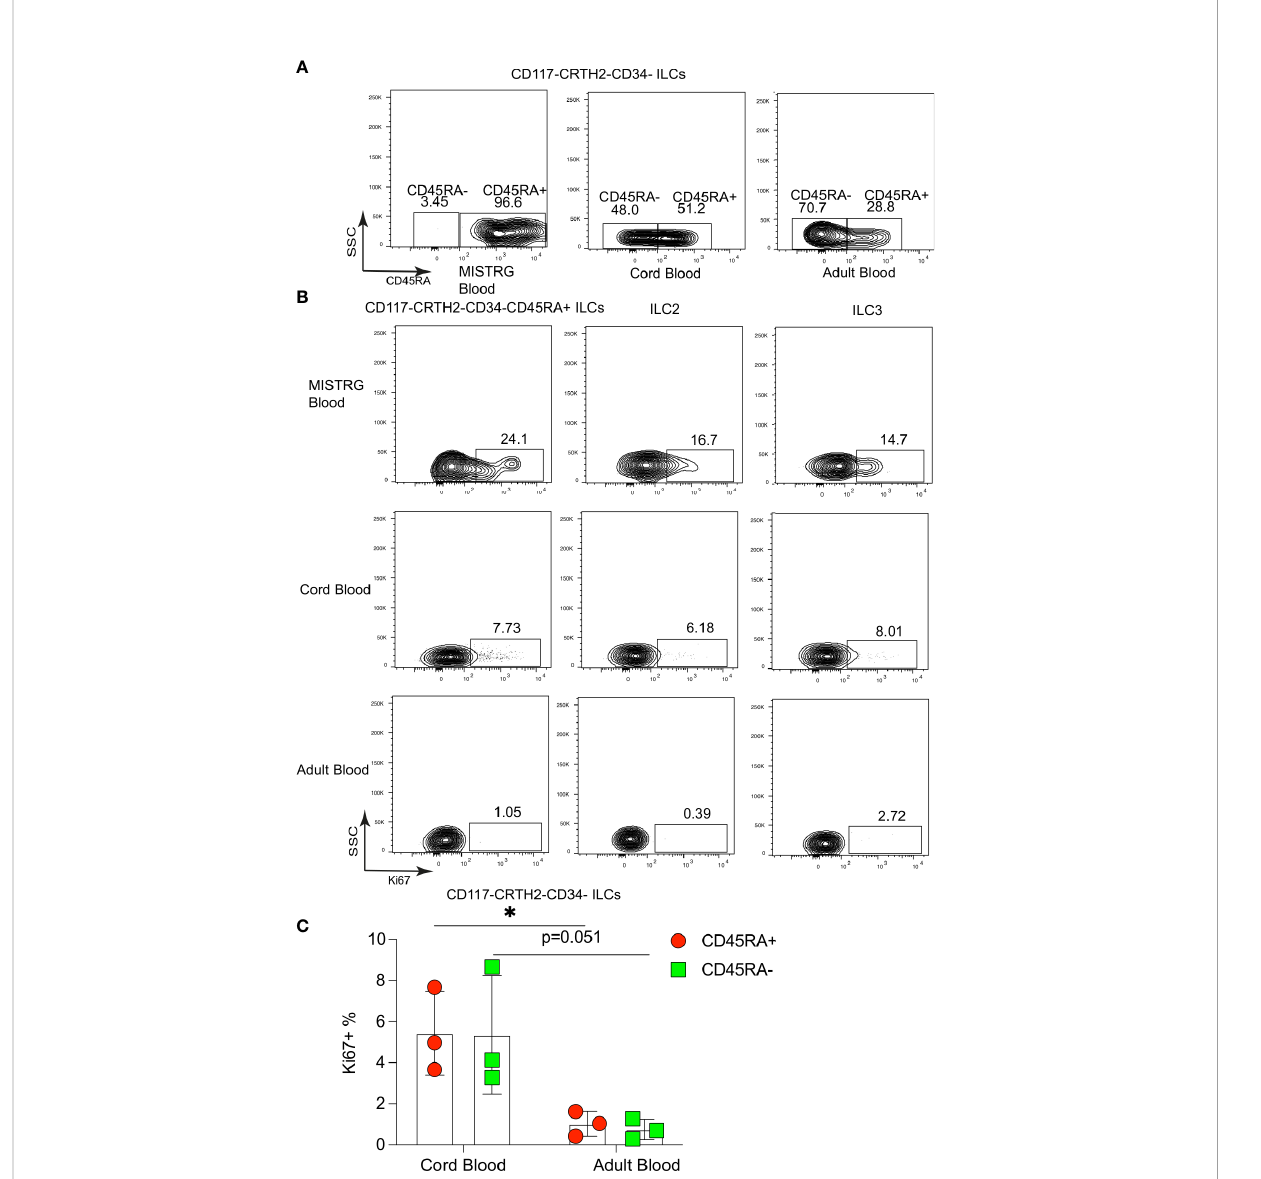
FIGURE 5 Proliferative CD117 - CRTH2 - CD45RA + ILCs are present in the circulation and in human umbilical cord blood. (A) CD45RA surface expression by CD117 - CRTH2 - ILCs from the blood of HSPC-engrafted MISTRG mice, human umbilical cord blood, and human adult blood (n = 3). (B) Flow cytometry analysis of intracellular Ki67 expression by human CD117 - CRTH2 - CD34 - CD45RA + ILCs, CRTH2 + ILC2s, and CD117 + CRTH2 - ILC3s from the blood of HSPC-engrafted MISTRG mice as well as from human cord blood and human adult blood (n = 3). ILCs were gated as human CD45 + CD127 + CD94 - CD3 - TCR ab - Lin - cells as in Supplementary Figure 1. (C) Frequencies of Ki67 + human CD117 - CRTH2 - CD34 - CD45RA + and CD117 - CRTH2 - CD34 - CD45RA - ILCs in human cord blood and adult blood (n = 3). *, P <0.05 by Student ’ s t test. Data represent mean ± SEM and are from three independent